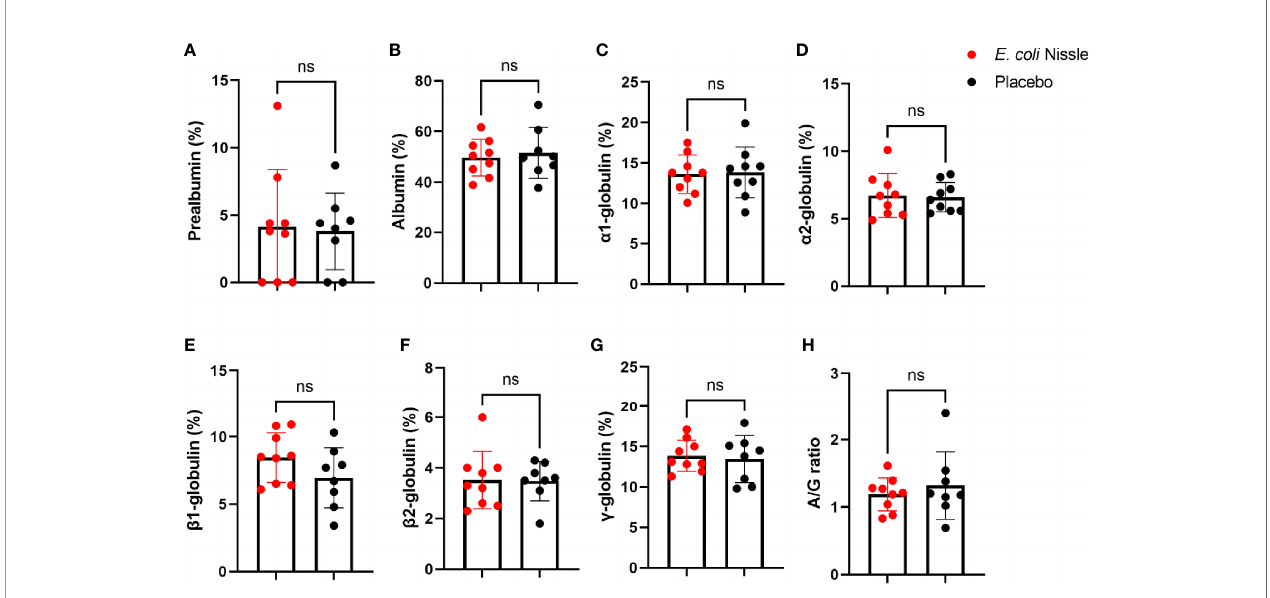
FIGURE 5 | Levels of plasma proteins after oral administration of E coli Nissle. The percentage of prealbumin (A) , albumin (B) , a 1 (C) , a 2 (D) , b 1 (E) , b 2 (F) , and g (G) -globulins concentrations and the albumin/globulin (H) ratio of animals in the E coli Nissle (red dots) and placebo (black dots) groups Post-V are shown. Individual, means and standard deviation values are shown. Values were compared by unpaired student ’ s t -test (ns, not signi fi cant, 1 experiment, n = 9 in the E coli Nissle group and n = 8 in the placebo